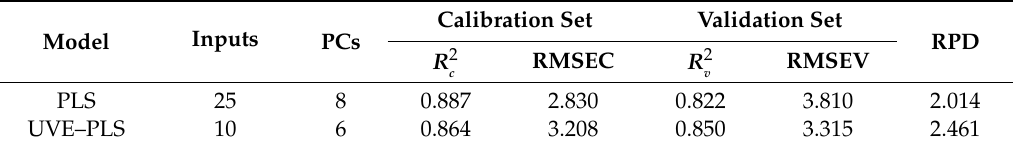
Table 6. Statistical results of SPAD value detection models.